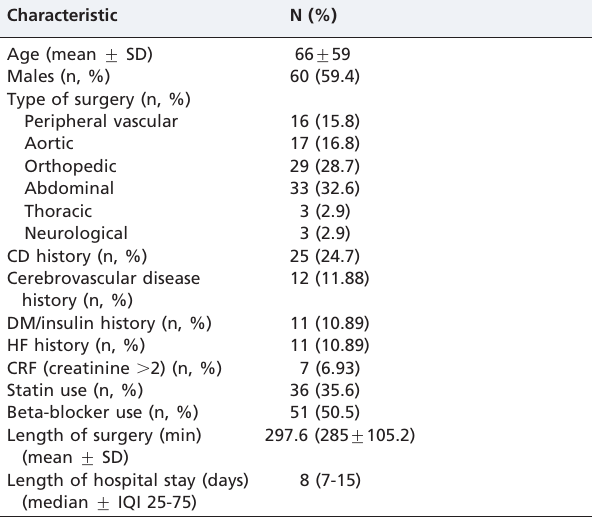
Table 1 - Baseline characteristics of the study